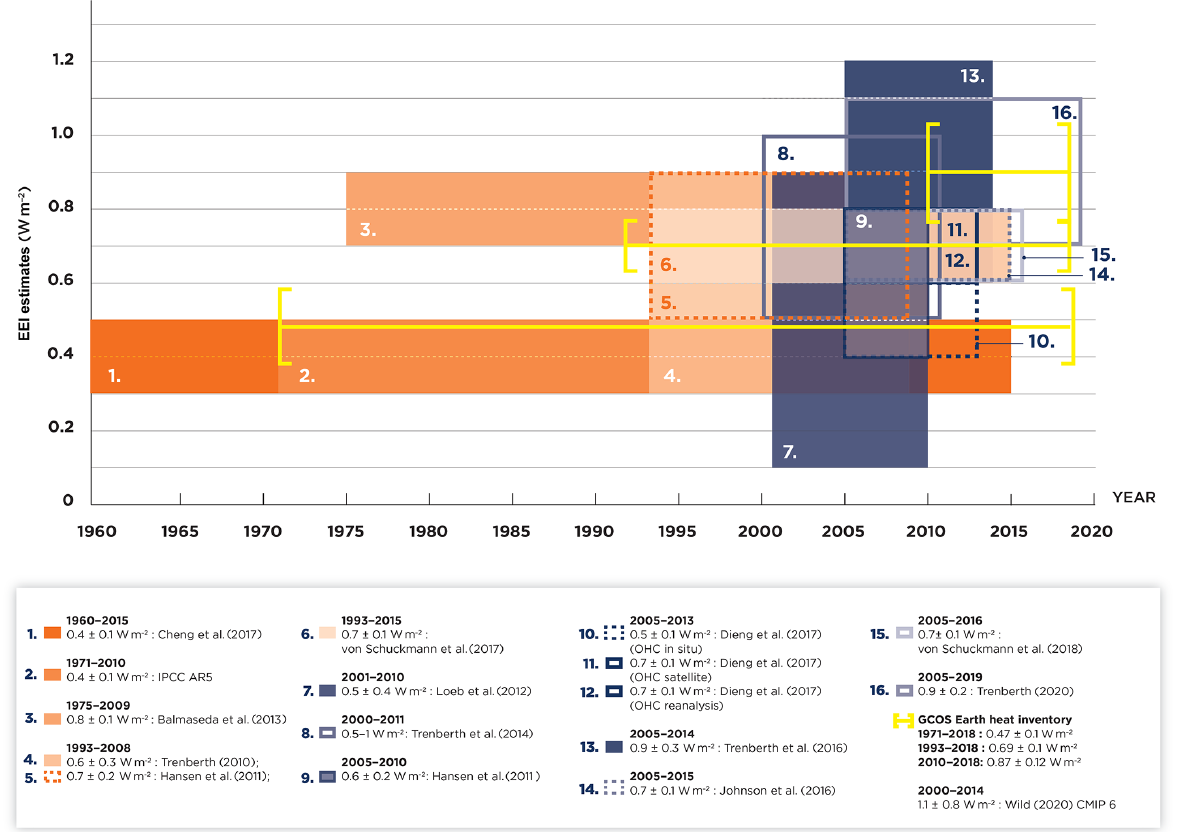
Figure 7. Overview on EEI estimates as obtained from previous publications; references are listed in the figure legend. For IPCC AR5, Rhein et al. (2013) is used. The color bars take into account the uncertainty ranges provided in each publication, respectively. For comparison, the estimates of our Earth heat inventory based on the results of Fig. 6 have been added (yellow lines) for the periods 1971–2018, 1993–2018 and 2010–2018, and the trends have been evaluated using a weighted least square fit (see von Schuckmann and Le Traon, 2011, for details on the